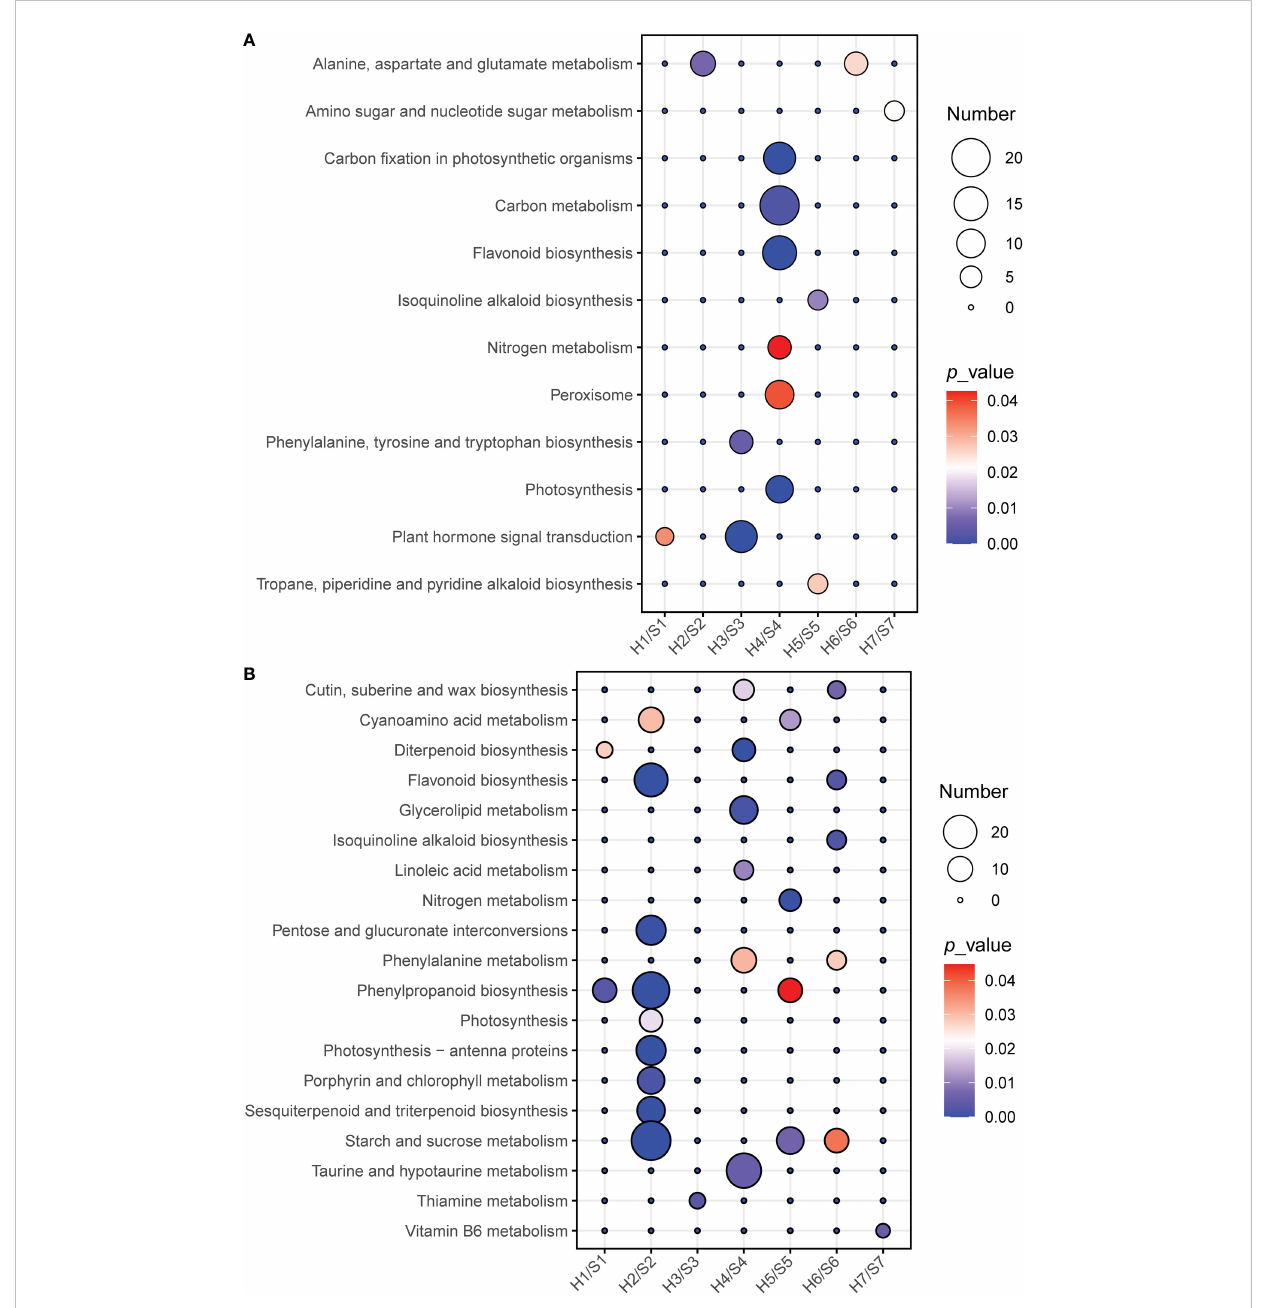
FIGURE 6 KEGG enrichment analysis of DEGs in the different of sweet potato cultivars under the drought stress. (A) , KEGG enrichment of up-regulated DEG, statistics of pathway enrichment ( P <0.05), (B) , KEGG enrichment of down-regulated DEG, statistics of pathway enrichment ( P < 0.05). The number of DEG is distinguished by the size of the circle and the circle from blue to red represents the P-value from large to small. H1/S1, drought-treated Shangshu-9/control Shangshu-9; H2/S2, drought-treated Chaoshu-1/control Chaoshu-1; H3/S3, drought-treated Xushu-22/control Xushu-22; H4/ S4, drought-treated Z15-1/control Z15-1; H5/S5, drought-treated Xushu-18/control Xushu-18; H6/S6, drought-treated Jishu-26/control Jishu-26; H7/S7, drought-treated Xuzi-8/control